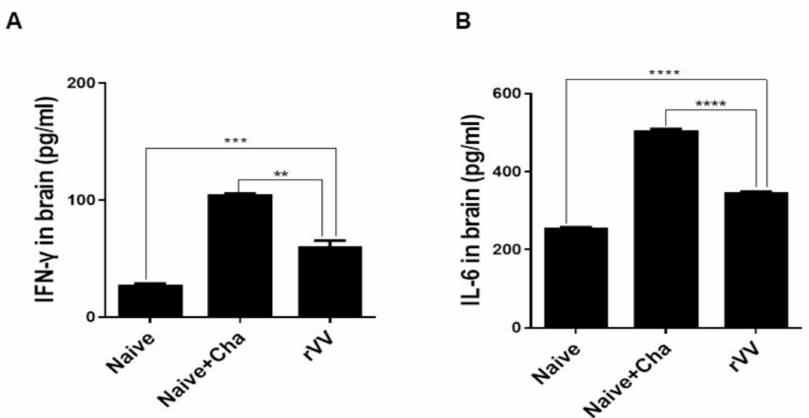
Figure 6. Immunization with ROP4-rVV vaccine inhibits inflammatory cytokine production. Brain tissues were isolated from mice and tissue homogenates were used to detect cytokines IFN- γ ( A ) and IL-6 ( B ) by ELISA. Data are presented as mean ± SD from 3 independent experiments performed in triplicates and asterisks indicate statistical differences between groups (** p < 0.01, *** p < 0.001, **** p <